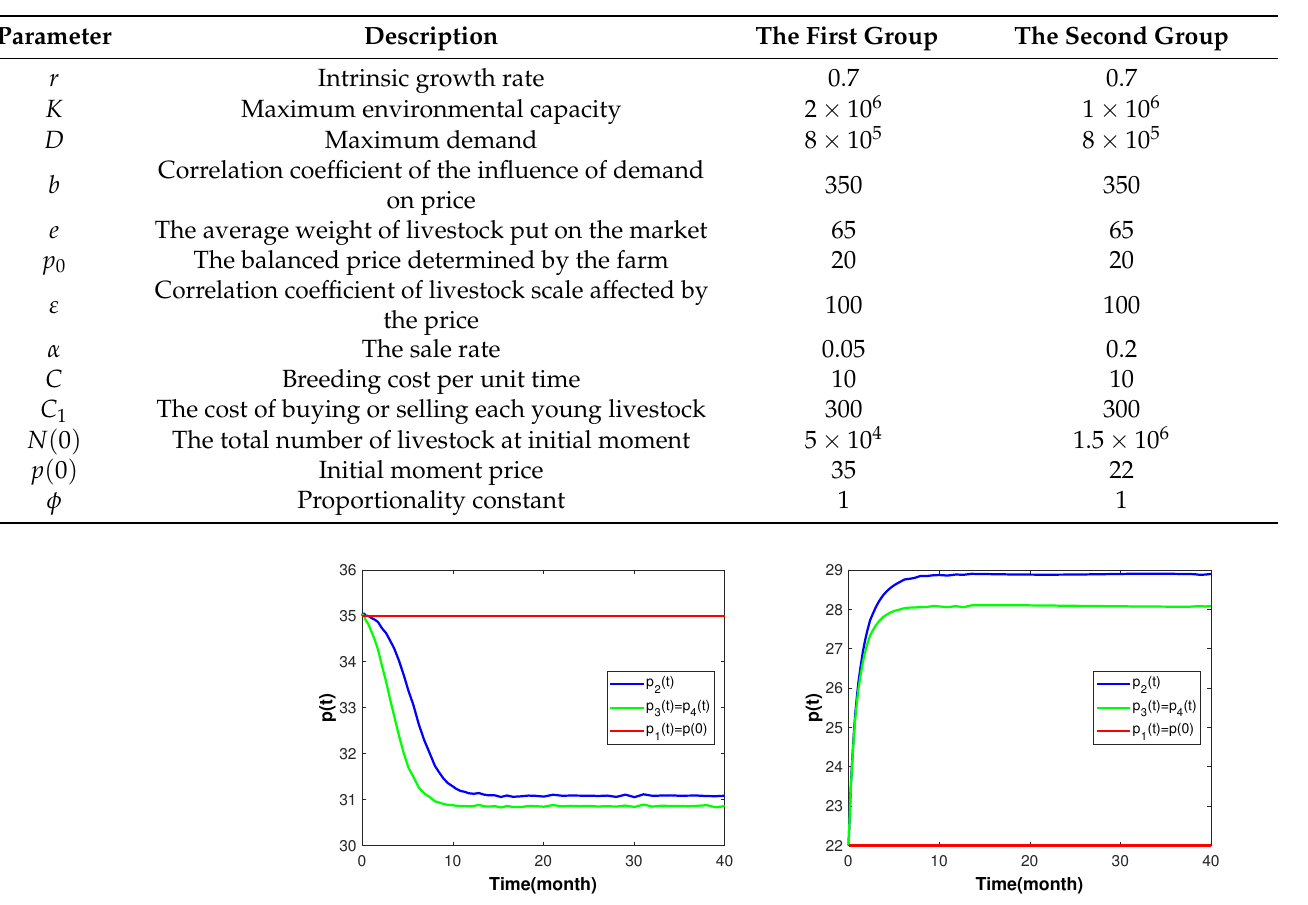
Table 1. Parameter description and two groups of parameter values.